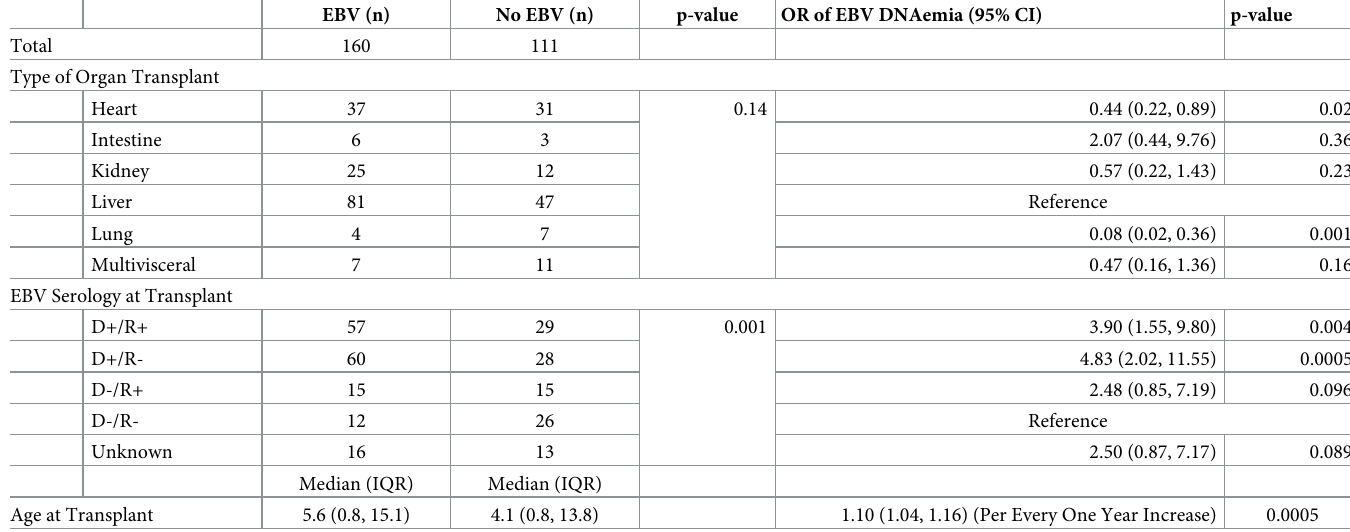
Table 4. The association between demographic characteristics and EBV DNAemia. Only significant risk factors are included in this table.